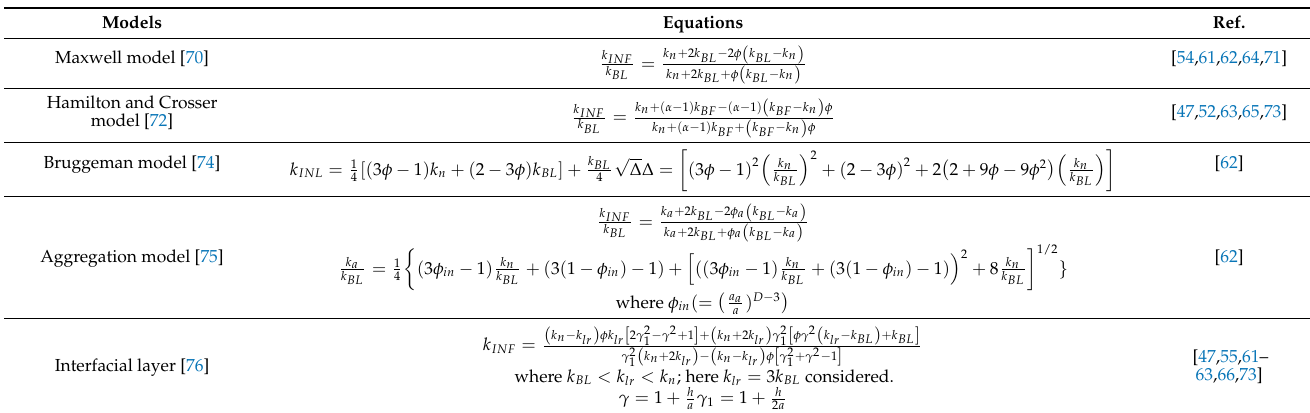
Table 3. Commonly used theoretical models to calculate the effective thermal conductivity of ILs-based nanofluids. Models Equations Ref. Maxwell model [70]